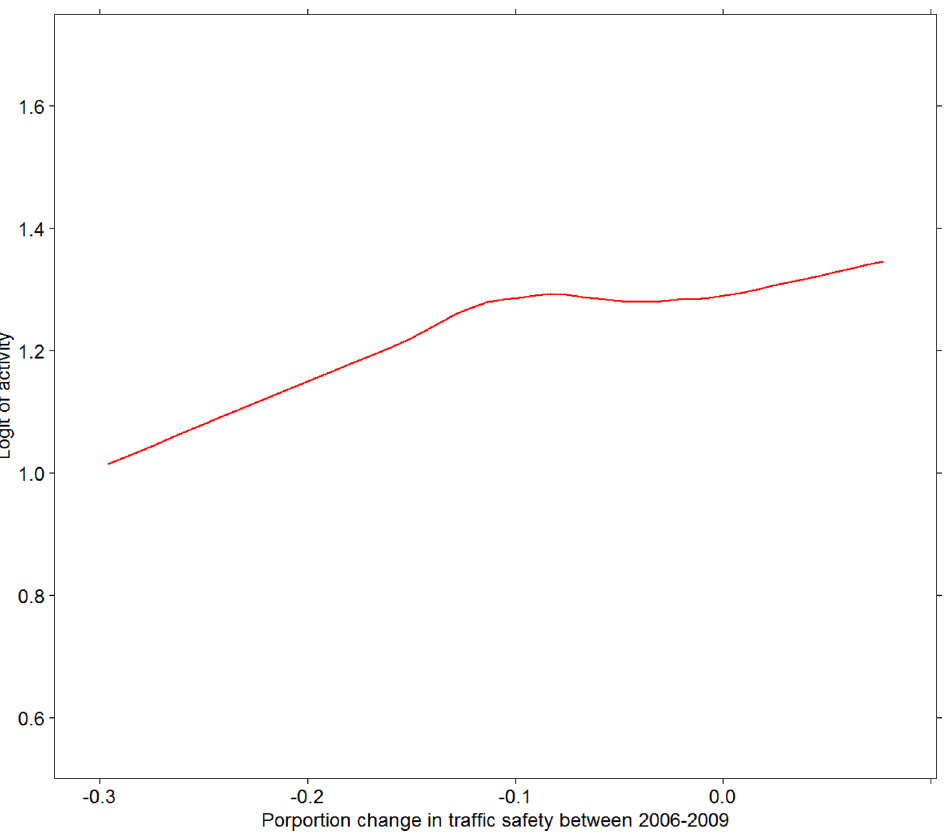
Figure 4. Prevalence of PA in 2009 in relation to change in traffic safety between 2006 and 2009. Prevalence of PA is measured as crude logit. Relationship depicted by a Loess curve based on 1 degree of freedom.